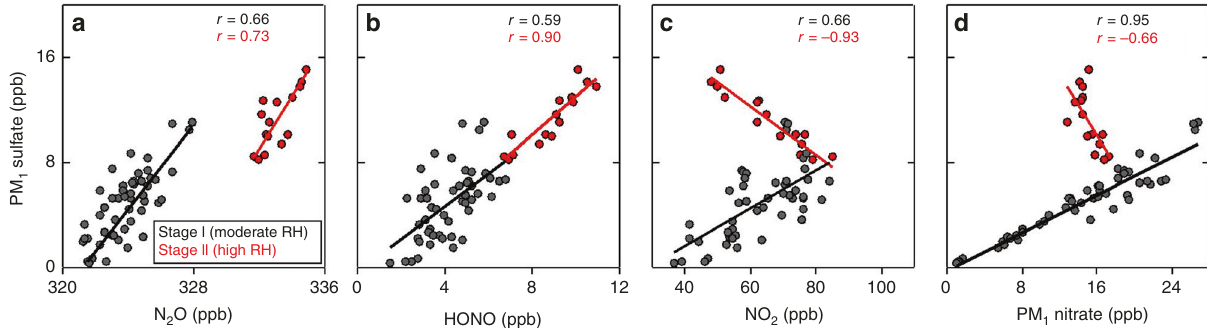
Fig. 3 Relationships between sulfate and nitrogen oxide concentrations. Data are shown for Stages I and II of the December 16 – 22, 2016 haze event. Concentrations of sulfate and nitrogen oxides are expressed in common parts per billion (ppb) units (1 μ g m − 3 sulfate = 0.23 ppb at T = 273.15 K). Individual points are hourly mean values from Fig. 1 during nighttime hours (19:00 – 6:00 local time). The fi gure shows scatterplots of PM 1 sulfate versus a nitrous oxide (N 2 O); b nitrous acid (HONO); c nitrogen dioxide (NO 2 ); d PM 1 nitrate. Pearson correlation coef fi cients ( r ) and reduced-major-axis regression lines are shown separately for Stages I and